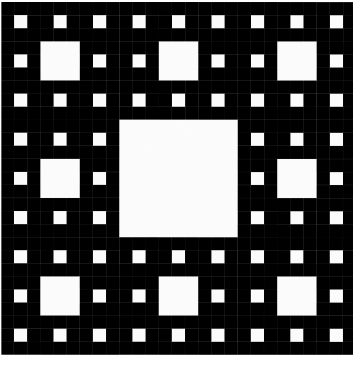
Figure 1. The third segmentation step of SC (3 ;